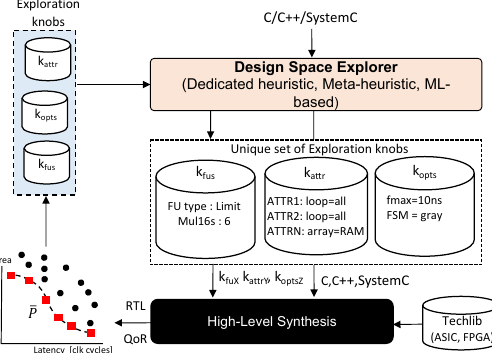
Figure 7. Micro-architectural HLS design space exploration